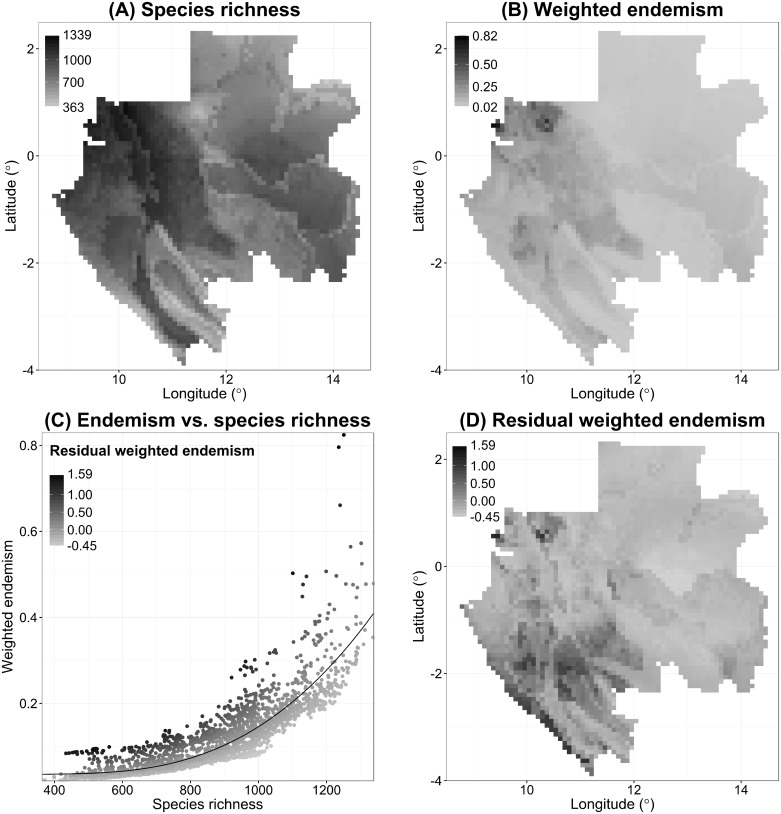
Botanical diversity patterns for Gabon based on 2089 species.The following diversity patterns are shown based on thresholded SDMs of 2089 Gabonese plant species: (A) total species richness; (B) weighted endemism; (C) weighted endemism (y-axis) plotted against total species richness (x-axis) with shades of grey indicating values of residual weighted endemism and the black curve representing a fourth-order polynomial function; (D) residual weighted endemism.